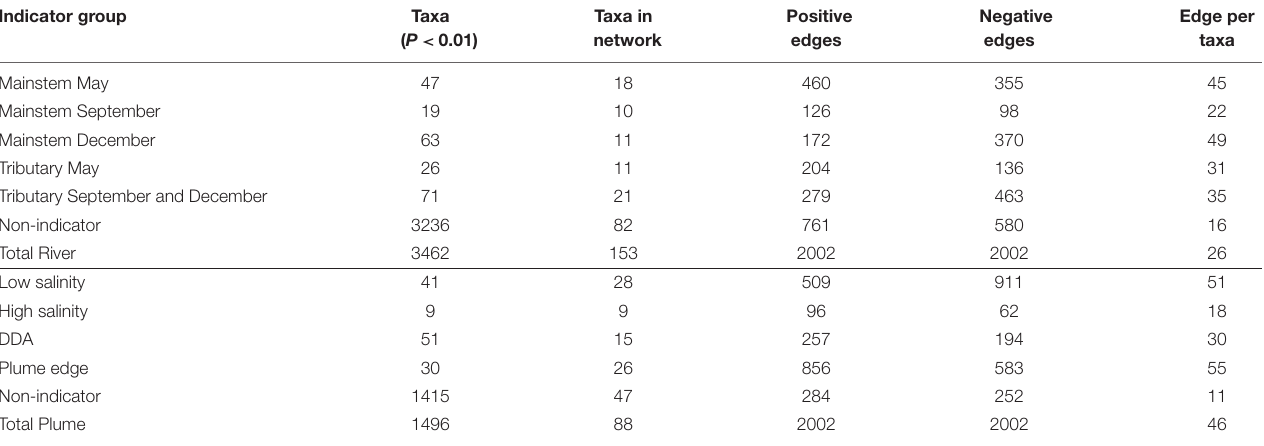
TABLE 3 | Number of indicator taxa for sample groups, and results of co-occurrence network analyses showing the number of taxa included, the number of positive and negative correlations (edges), and the number of correlations per taxa for each indicator group. Indicator group Taxa ( P <